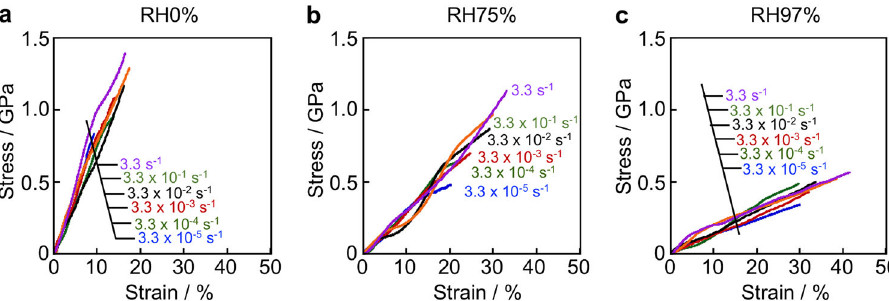
Fig. 6 Humidity effects on stress-strain curves of spider dragline silk fi bers. Stress – strain curves of spider dragline silk fi bers at a RH0%, b RH75%, and